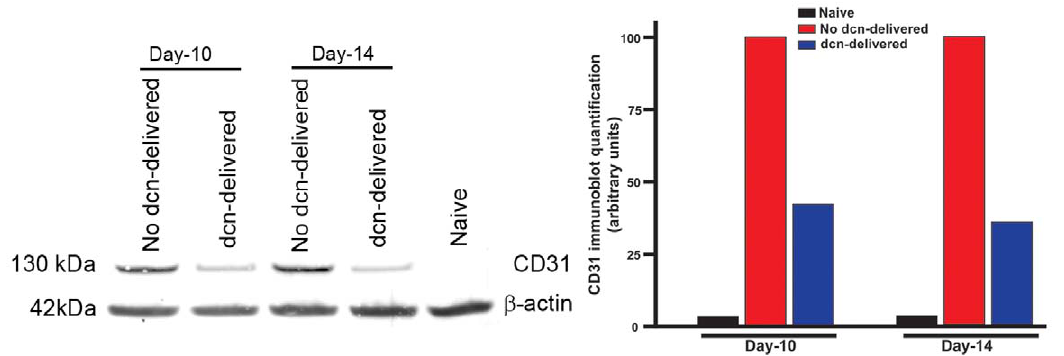
Figure 6. CD31 Western blot for naive, AAV5 + / 2 decorin-delivered rabbit corneal tissues collected 10 and 14 days after VEGF- implantation. Panel on left side shows immunoblot and on right side shows quantification of western blotting data collected from corneal tissues of day-10 and day-14. A significant decrease in expression of CD31 on day-10 (62%, p , 0.05) and day-14 (66%, p , 0.05) was detected in decorin- delivered corneas compared to control corneas suggesting that AAV5-mediated decorin gene therapy is efficient in decreasing CNV. b -actin was used to confirm equal loading of protein in each well and normalization of the data. dcn=decorin.